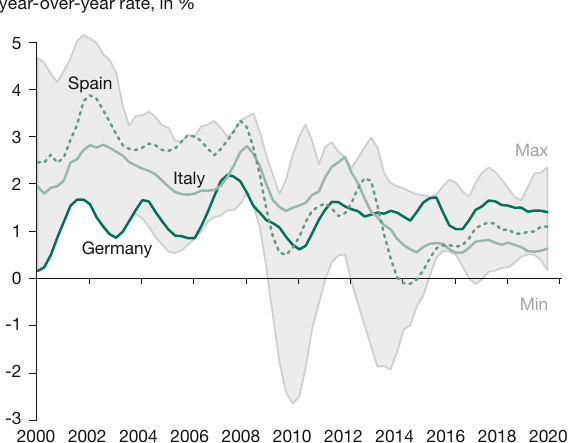
Core HICP infl ation in the eurozone, 2000-20 year-over-year rate, in